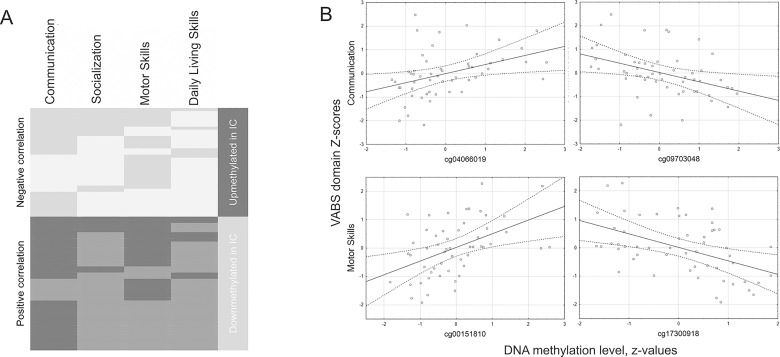
Associations between Z-scores on the four VABS domains and the methylation levels (z-values) of CpG sites differentially methylated in IC children.(A) Clustergram depicting correlations for 78 DMESs (rows) that showed a significant (pnominal < 0.05) association with at least one VABS domain. Negative and positive associations are shown in light grey and dark grey, respectively; the color saturation denotes p-values—lighter for a pnominal > .05 and darker for pnominal < .05. The last column encodes the direction of methylation level difference (up- and downmethylation) in the IC group. (B) Scatterplots representing correlations between CpGs methylation levels and VABS scores; four significant (padj < .05) associations are shown.